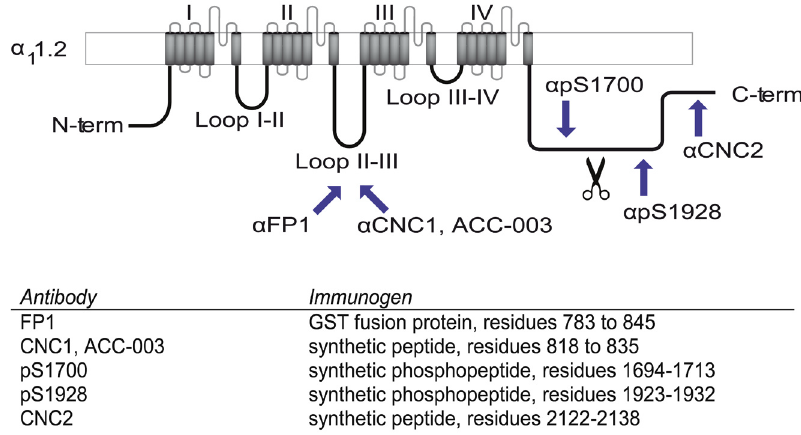
Figure 1. Location of antibody epitopes. Shown is a schematic of the Ca 1.2 α 1.2 subunit, in which regions used as immunogens for v 1 the depicted antibodies are identified by arrows. Exact residues are listed in the table and numbered according to α 1.2 given in Gene 1 Bank Accession number CAA33546. FP1, CNC1, and ACC-003 are directed against the loop between domains II and III, pS1700 against phosphorylated S1700, pS1928 against phosphorylated S1928, and CNC2 against residues 2122-2138 of α 1.2, which are ~40 residues 1 upstream of the very C terminus of α 1